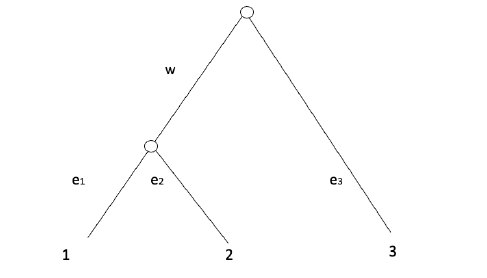
Figure 1. Example of a phylogenetic tree T on the label set of leaves X = { 1,2,3 } . Internal nodes on T do not have labels. The internal node of the ancestor of leaves 1, 2 represents the most common ancestral species of species 1, 2 and the root of T is the most common ancestor of all species 1, 2, 3 . Each branch length on a branch represents the mutation rate combined with its evolutionary time. A distance matrix computed from this tree shown in Figure 1 is a 3 × 3 matrix such that d ij , the ( i , j ) th cell of the matrix d is the total branch length from a leaf i ∈ X to a leaf j ∈ X, that